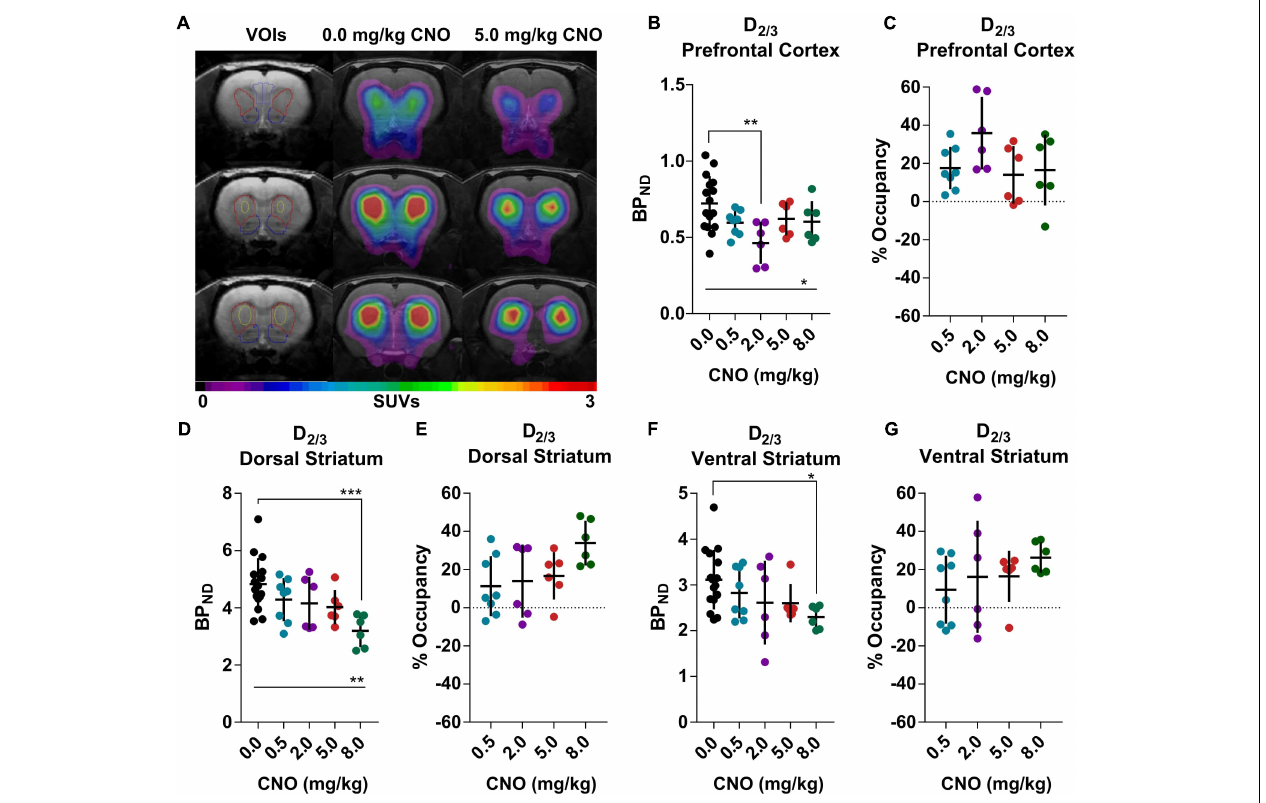
FIGURE 1 | [ 18 F]Fallypride binding in the rat prefrontal cortex and striatal regions (A) , 5 mg/kg Clozapine N-oxide (CNO) induced a noticeable decline in receptor availability in the same rat (A) . CNO induced occupancy on a group level at the dopamine D 2 / 3 receptors in the prefrontal cortex (B,C) as well as dorsal (D,E) and ventral (F,G) striatum. Horizontal lines and ∗ represents a significant effect of treatments, as measured with a one-way ANOVA ( ∗ p < 0.05, ∗∗ p < 0.01 and ∗∗∗ p < 0.001).